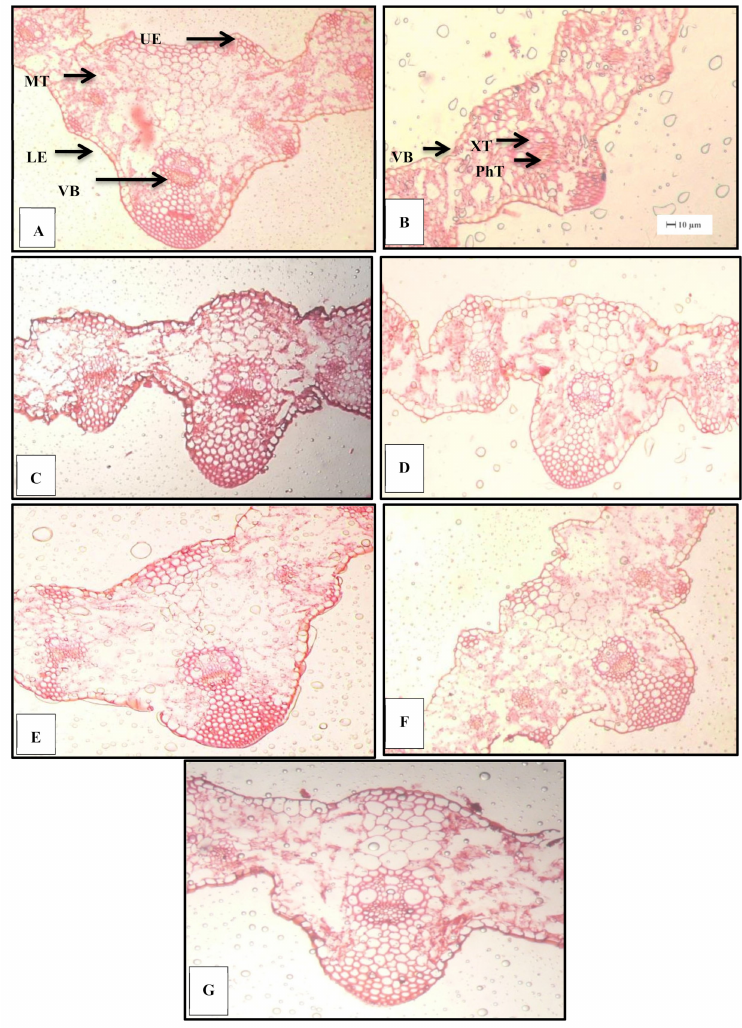
Figure 6. Transverse sections in flag leaves of barley plants in the second season. ( A ) Control (well-watered). ( B ) Plants received one irrigation (D1). ( C ) Plants received two irrigations (D2). ( D ) Plants received one irrigation and treated with biochar (D1 + BC). ( E ) Plants received one irrigation and treated with chitosan (D1 + CH). ( F ) Plants received two irrigations and treated with biochar (D2 + BC). ( G ) Plants received two irrigations and treated with chitosan (D2 + CH). ( × 200). UE: upper